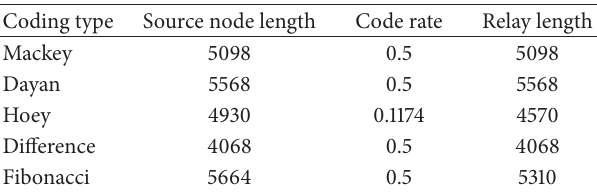
Figure 4: The BER curve comparison of QC-LDPC constructed by Hoey sequence, PEG algorithm codes, and array codes. Table 1: The parameters of Figure